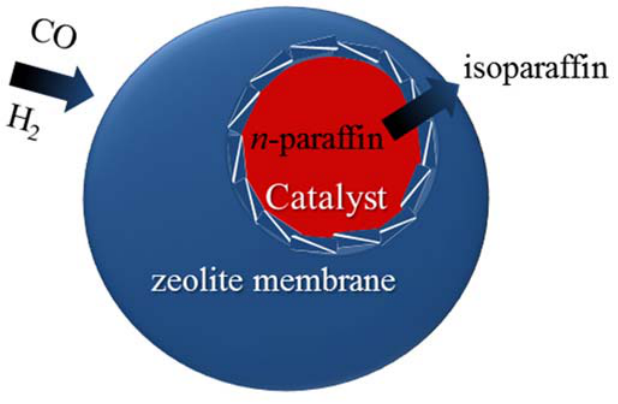
Figure 12. Schematic drawing of a core/shell catalyst in the synthesis of i -paraffins